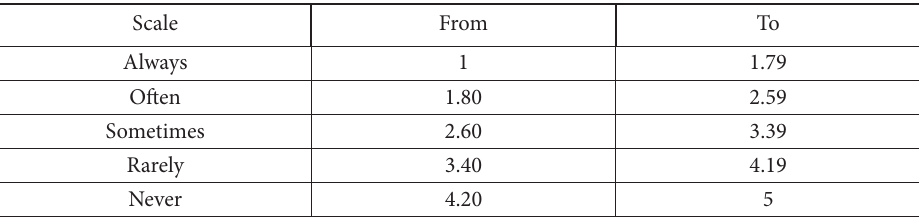
Table 1. Weighted average of Likert scale used in the present study (source: created by